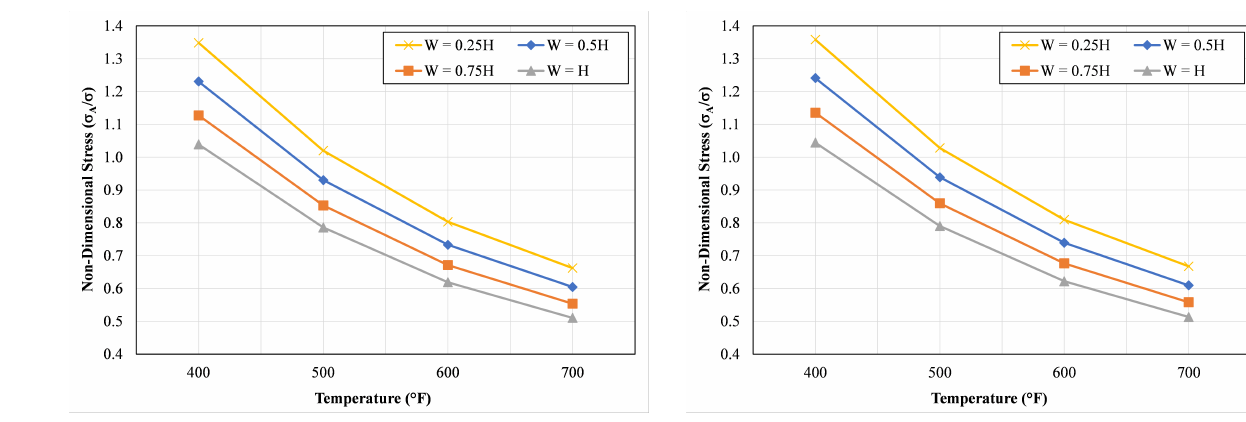
Figure 11: Relationship between σ A / σ on the expansion loop pipe 24-inch diameter with increasing temperature.